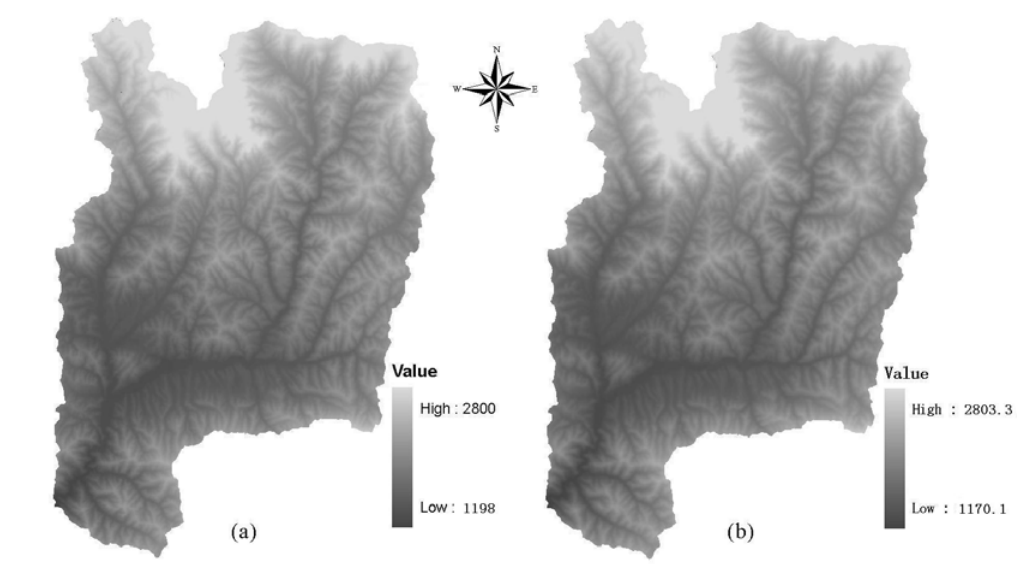
Figure 1. Different spatial resolution DEMs of the Yangjiahe river watershed, (a) represents the 30m DEM constructed with 1:50,000 topographic map; (b) represents the 30m DEM re-sampled with 90 m SRTM DEM.